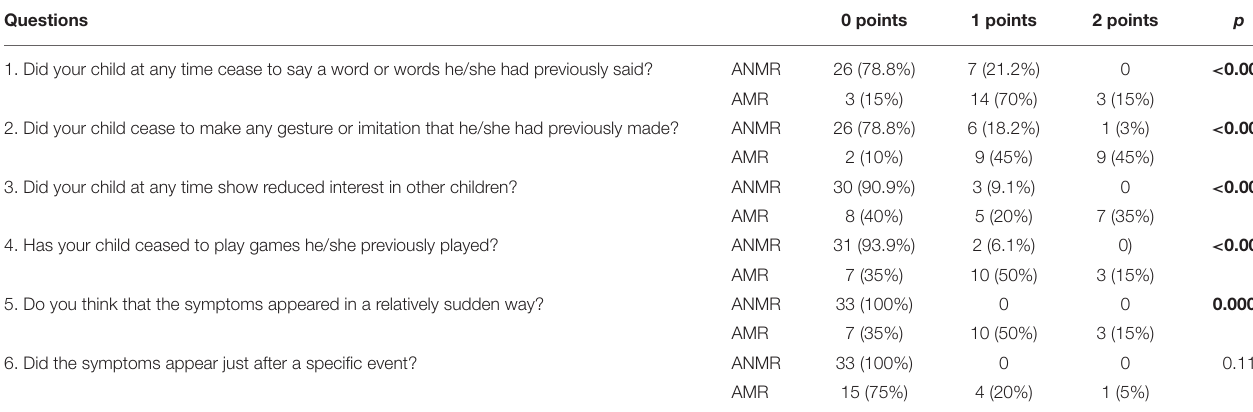
TABLE 2 | Number and percentages of answers on the test to classify children with autism spectrum disorder according to neurodevelopmental and non-neurodevelopmental regression.